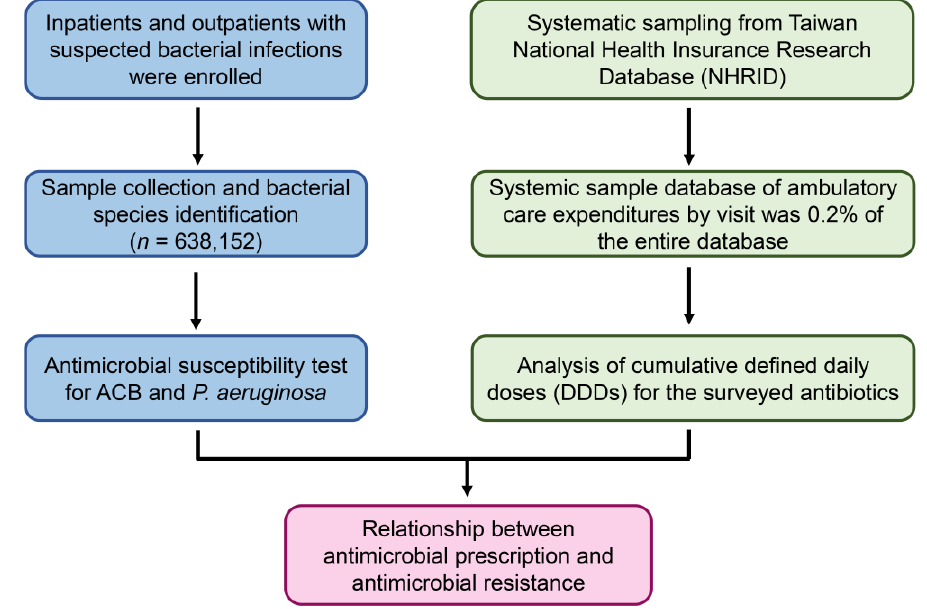
Figure 1. Flowchart of sample collection, antimicrobial determination, and defined daily doses (DDD) analysis. Acinetobacter calcoaceticus-Acinetobacter baumannii complex (ACB) and P. aeruginosa were isolated from the hospitalized patients and outpatients, and the antimicrobial susceptibility